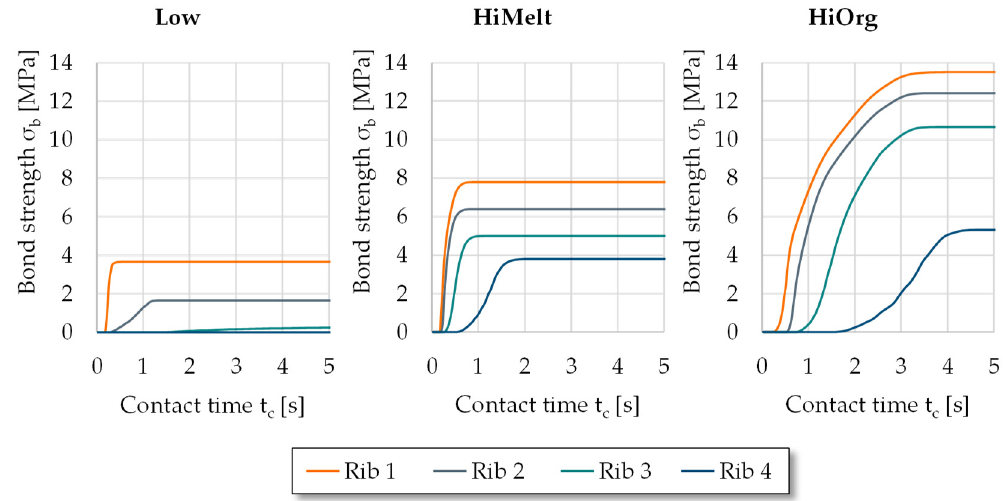
Figure 14. Bond strength vs. contact time for the individual ribs depending on low process temperatures (“Low”), a high melt temperature “HiMelt”, and a high organo sheet temperature “HiOrg” (cf. Table 1).